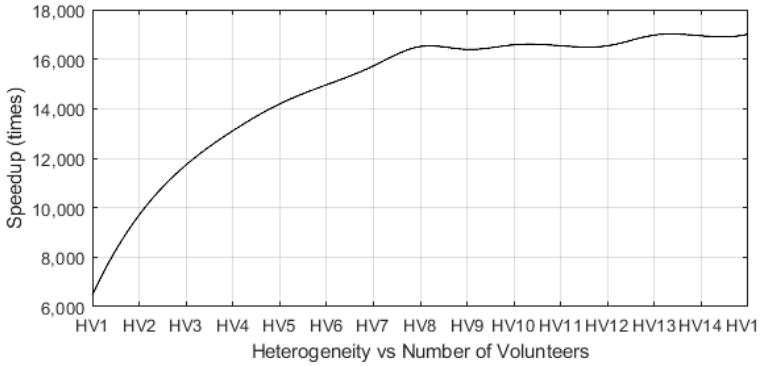
Figure 4. The speedup vs. the evaluation pairs.